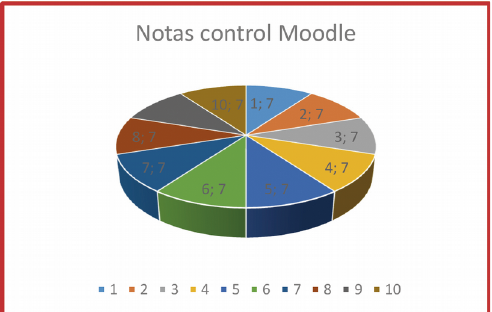
Figure 21. Moodle control grades (Where 1;7 stands for Student; Grade)